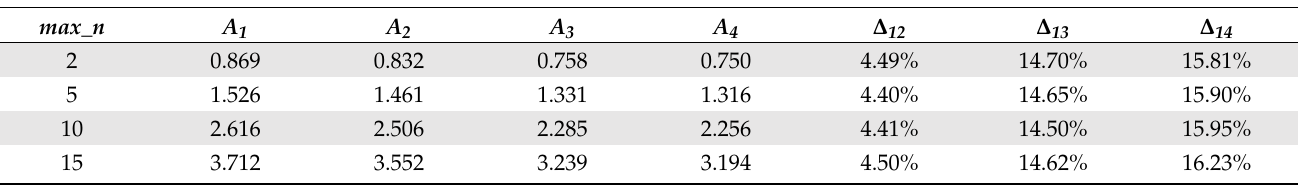
Table 3. Results obtained from simulation. num_rounds = 100,000. ∆ 1 i =